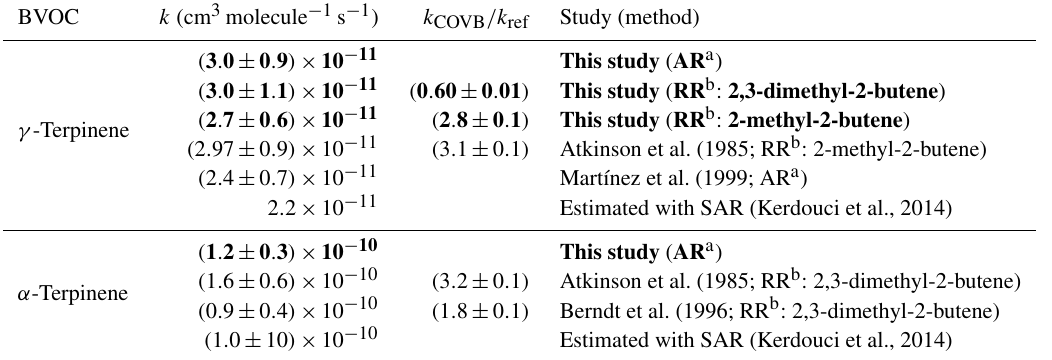
Table 2. Rate constants for the NO 3 -initiated oxidation of γ -terpinene and α -terpinene: results from this study and comparison with the literature. The bold values are the values measured in our